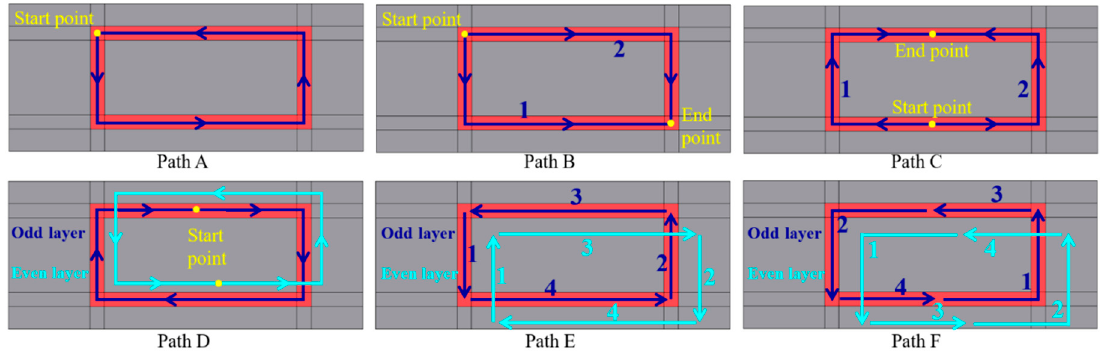
Figure 7. Schematic of six different building strategies for rectangular parts in L-DED.